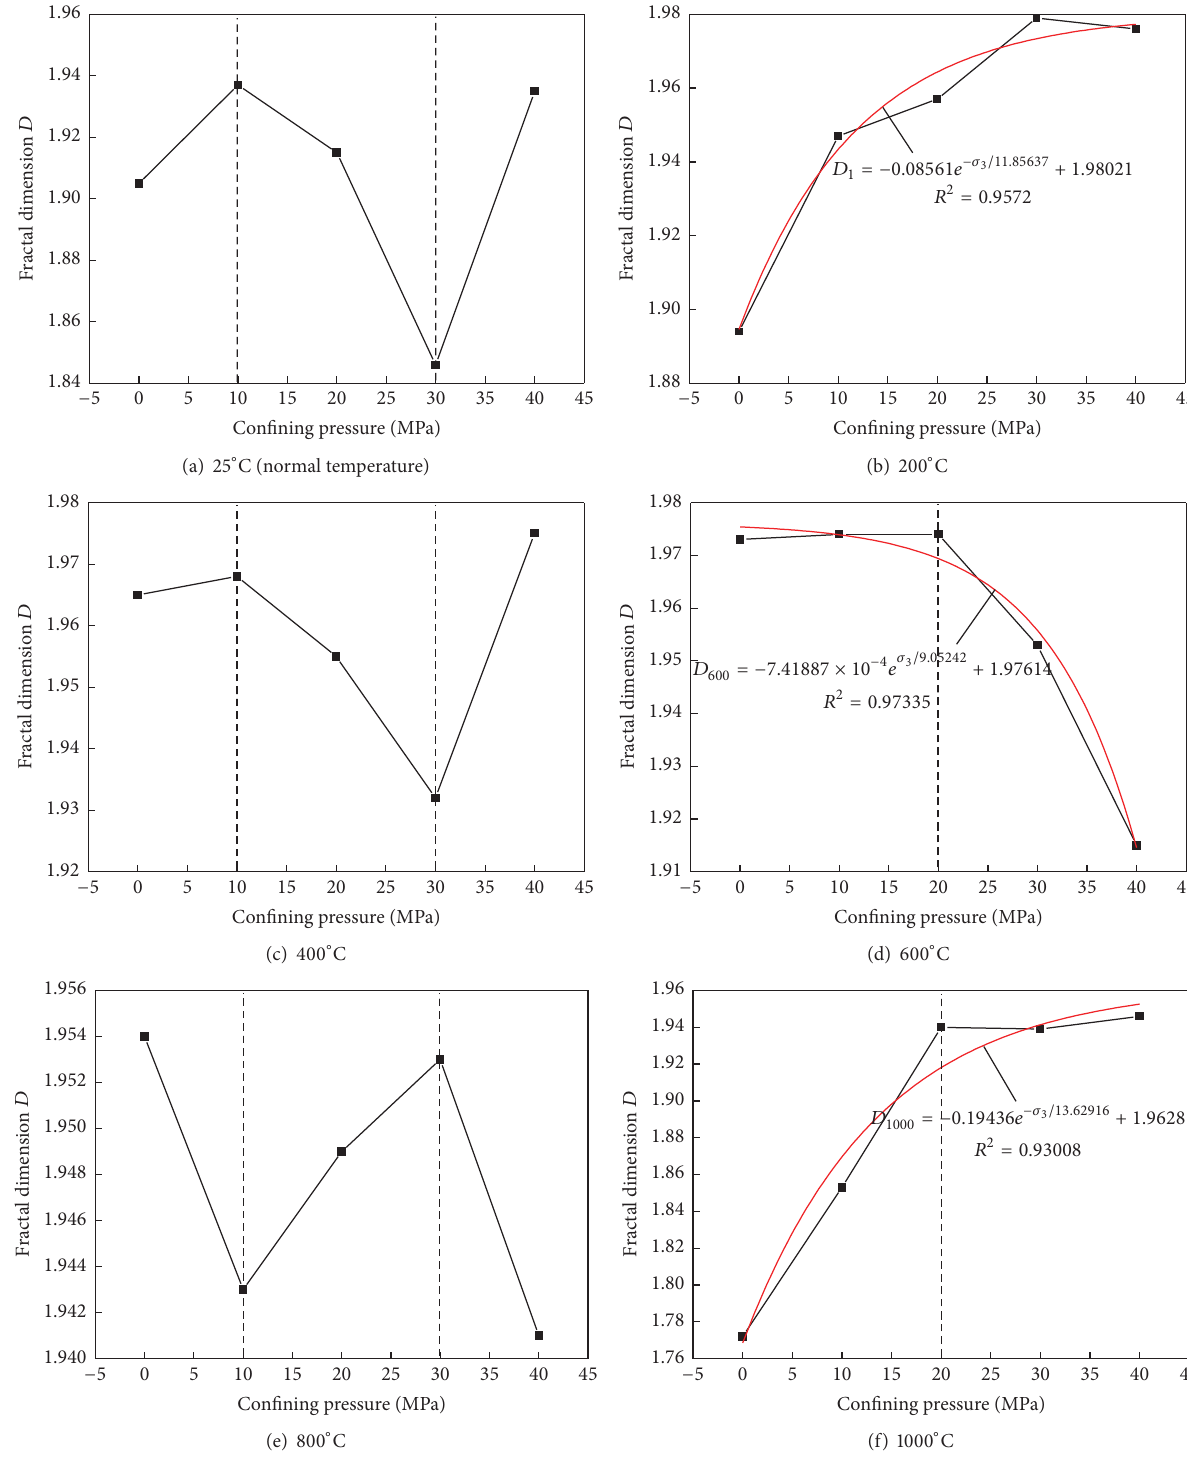
Figure 5: Relationship between fractal dimension and confining